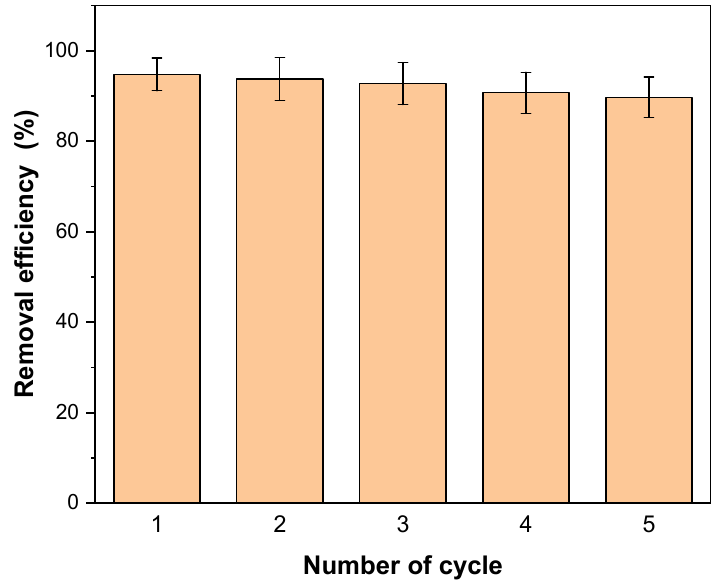
Figure 15. The cycles of photocatalytic experiment of B–ZnO/TiO 2 after five cycles (initial MB concentration: 15 mg/L; photocatalyst amount: 30 mg; pH: 11; irradiation time: 15 min).